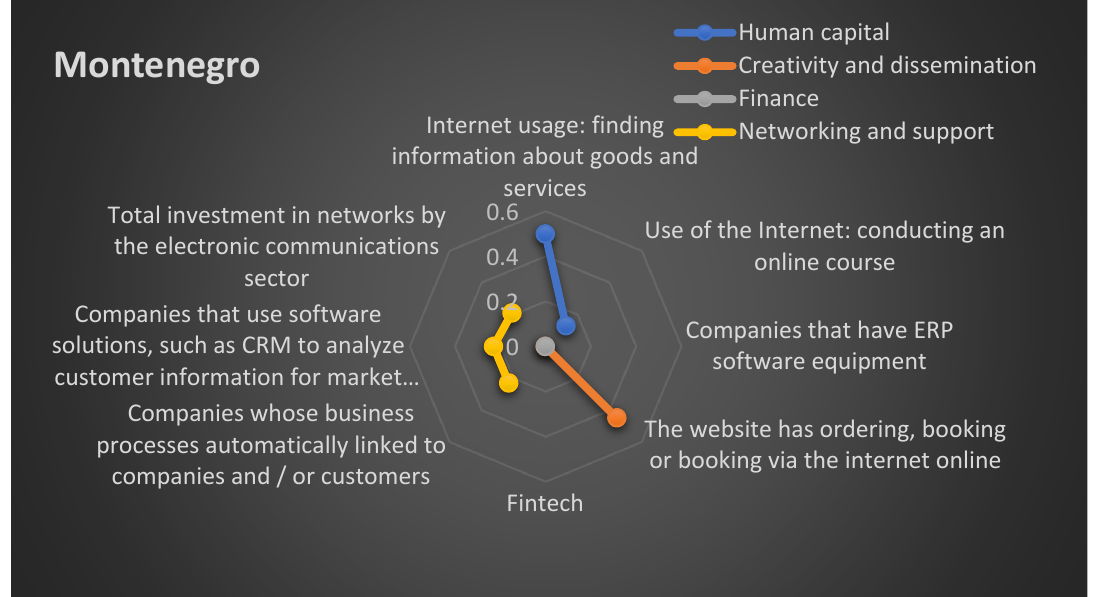
Figure 3. Values of factors of the digital entrepreneurial system of Montenegro, in the scale-up phase of the life cycle of the enterprise, in the digital dimension.